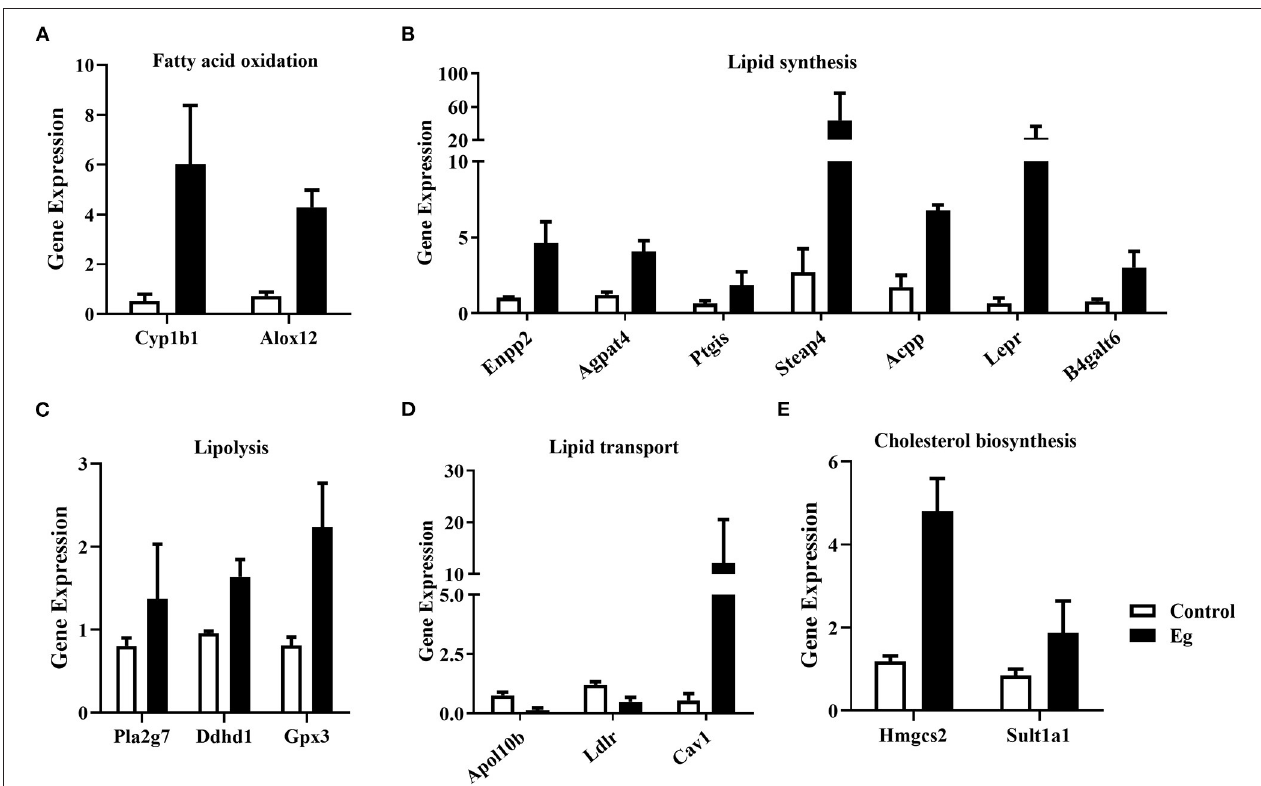
FIGURE 6 | The expression profile of the key genes involved in lipid metabolism in the splenic B cells infected with the larval E. granulosus . The expression levels of genes related to fatty acid oxidation (A) , lipid synthesis (B) , lipolysis (C) , lipid transport (D) , and cholesterol biosynthesis (E) were shown. n = 3 mice per group. Cyp1b1, cytochrome P450, family 1, subfamily b, polypeptide 1; Alox12, arachidonate 12-lipoxygenase; Enpp2, ectonucleotide pyrophosphatase/phosphodiesterase 2; Agpat4, 1-acylglycerol-3-phosphate O-acyltransferase 4; Ptgis, prostaglandin I2 (prostacyclin) synthase; Steap4, STEAP family member 4; Acpp, acid phosphatase, prostate; Lepr, leptin receptor; B4galt6, UDP-Gal:beta GlcNAc beta 1,4-galactosyltransferase, polypeptide 6; Pla2g7, phospholipase A2, group VII (platelet-activating factor acetylhydrolase, plasma); Ddhd1, DDHD domain containing 1; Gpx3, glutathione peroxidase 3; Apol10b, apolipoprotein L 10b; Ldlr, low density lipoprotein receptor; Cav1, caveolin 1, caveolae protein; Hmgcs2, 3-hydroxy-3-methylglutaryl-Coenzyme A synthase 2; Sult1a1, sulfotransferase family 1A, phenol-preferring, member